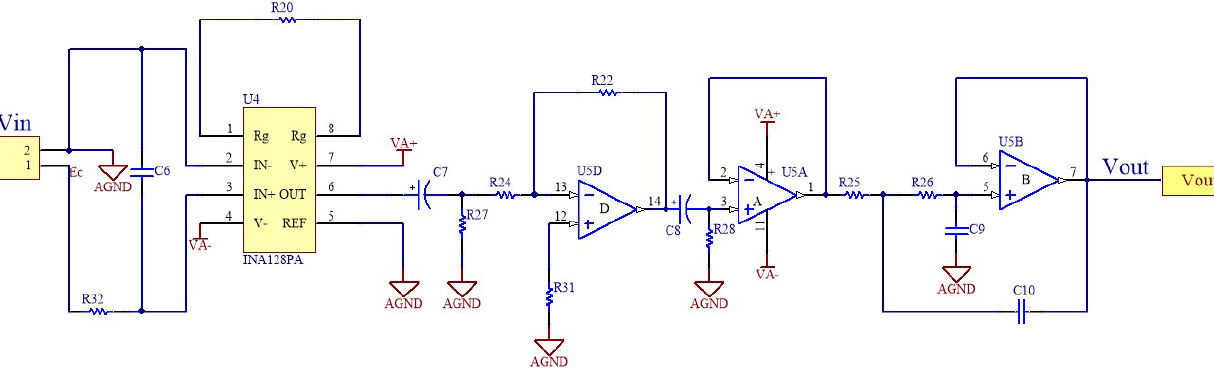
Figure 3. Schematic diagram of the coil channel acquisition